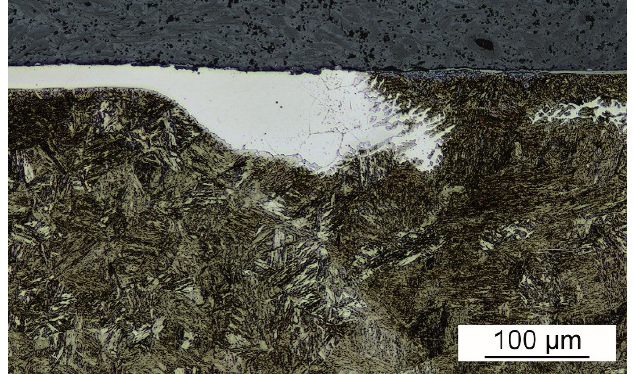
Figure 6. Surface area of hybrid weld made with 40 A (signed with a yellow rectangle in Figure 5). Three cross-sections of each weld were analyzed. Figure 7 presents the average cross- section areas of FZ and surrounding HAZ visible on macrographs. The error bars represent standard deviations. Both the FZ and HAZ broaden with increasing arc current. However, the increase in HAZ cross-section area is higher compared to FZ.